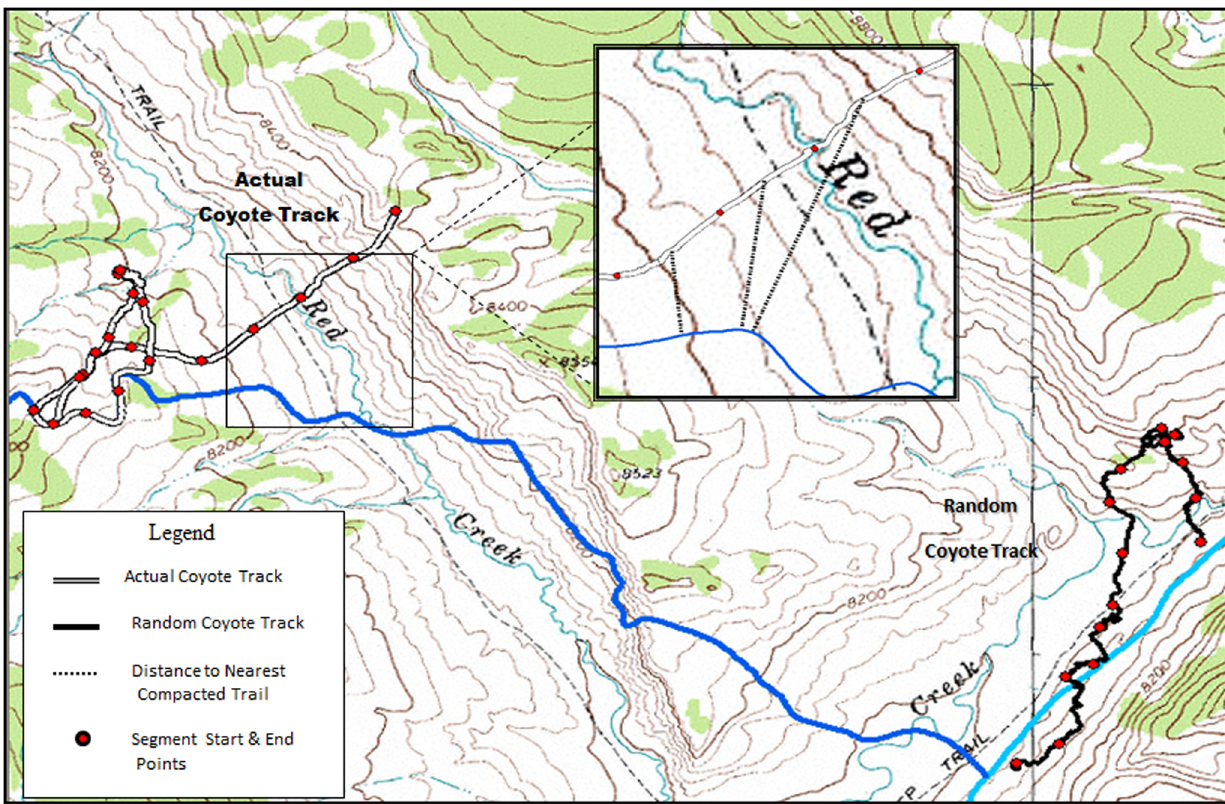
Figure 1. Comparison of an actual and random coyote track documented on 15 February 2008, Togwotee Pass, Wyoming. Inset shows how distance to nearest compacted trail was calculated by finding the centroid point for each segment within a given track and measuring the distance (m) to the nearest groomed snowmobile trail. Blue line denotes a snowmobile trail.